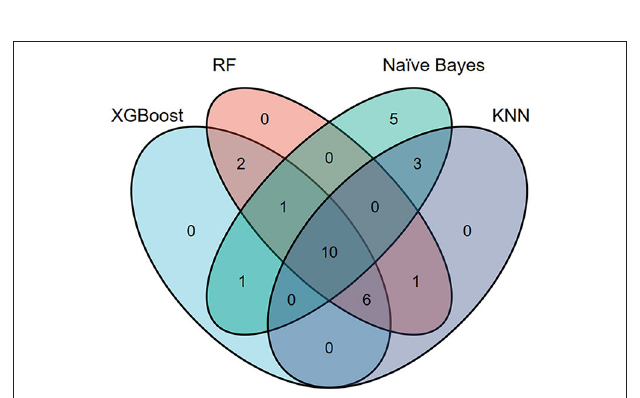
FIGURE 3 | Venn plot showing the most important features in each model for detecting referable diabetic retinopathy.